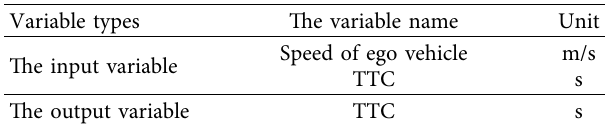
Figure 7: TTC estimation framework. Table 4: Input and output LSTM for car-following.